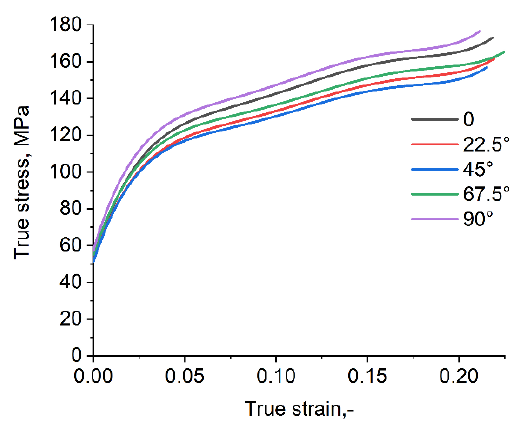
Figure 2. Fitted true stress–true strain curves for different directions.